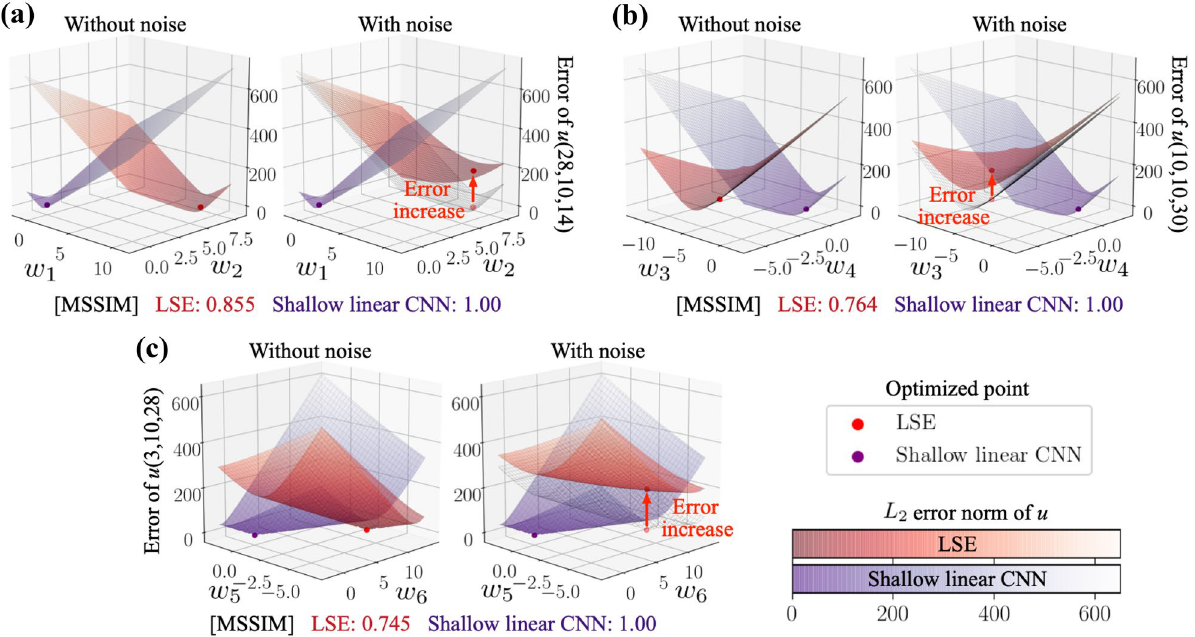
Figure 9. Error-surface analysis in the turbulent channel flow example. The axis x and y are arbitrary weights picked up from each